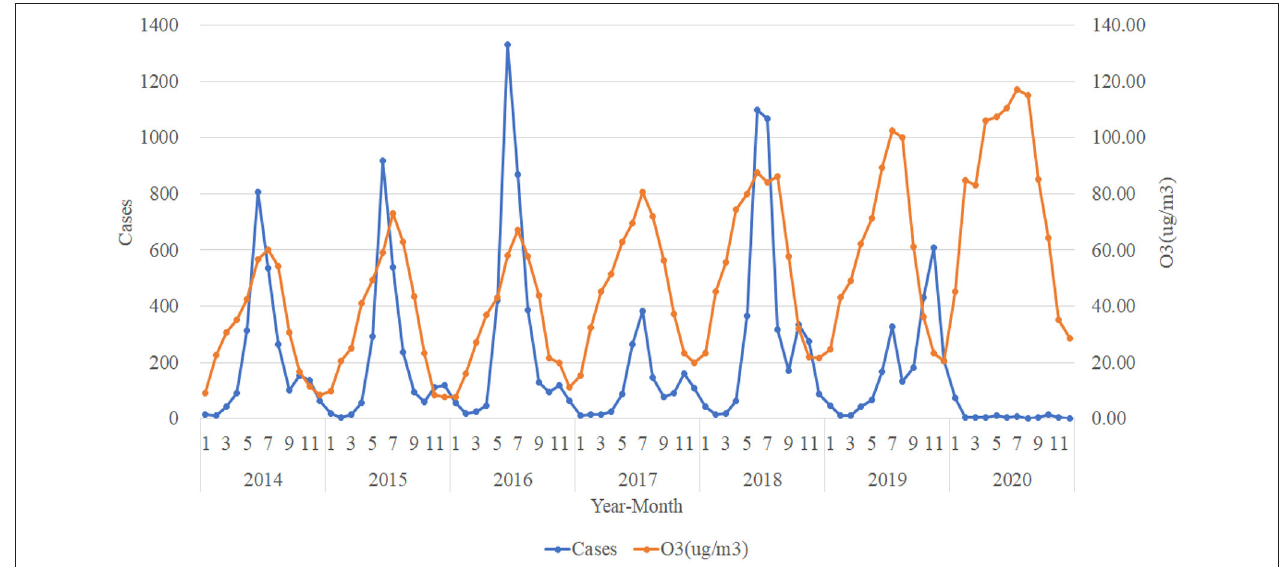
FIGURE 8 | Trends in the number of HFMD cases and O 3 (ug/m 3 ).